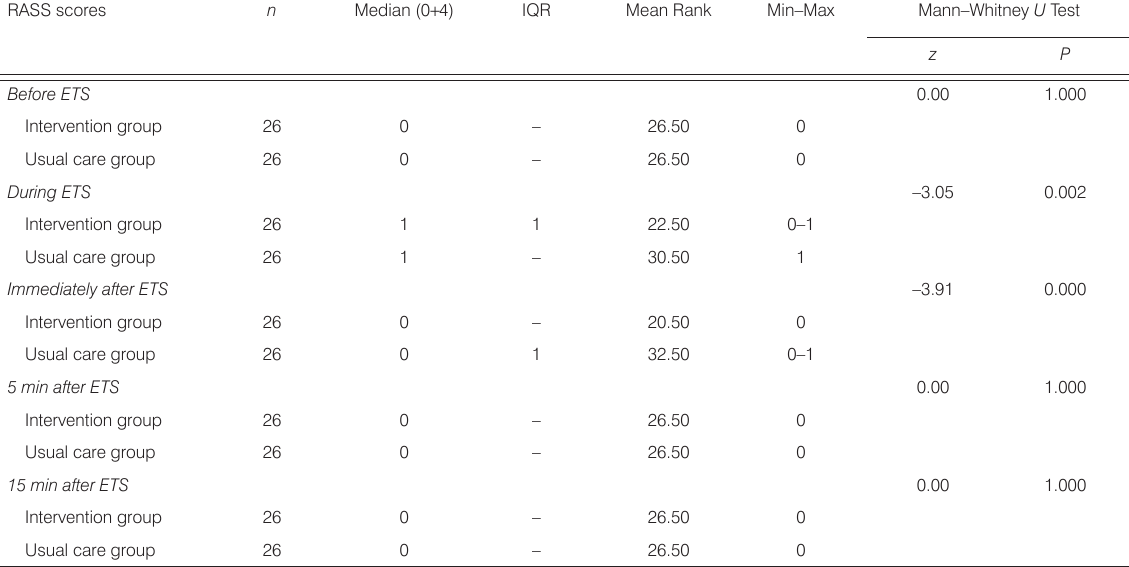
Table 2. Level of Agitation (RASS Scores) of the Study Participants in the Control and Intervention Groups ( N = 52).